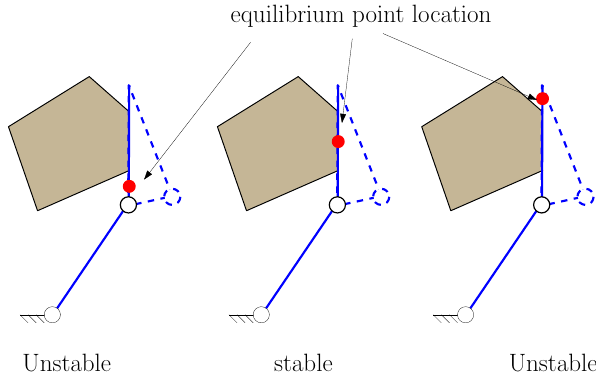
Figure 9. Stability of a planar pinch grasp depending on the equi- librium location.